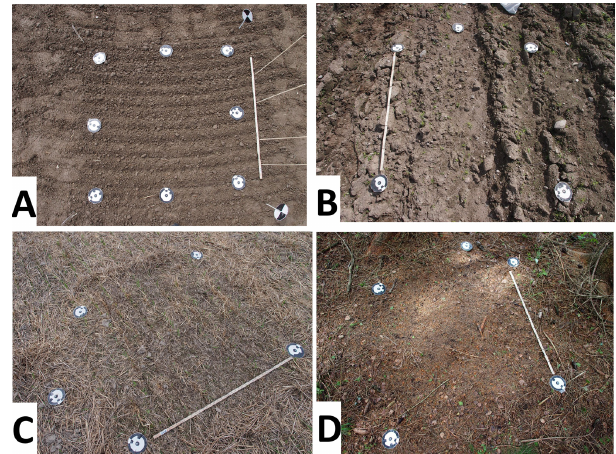
Figure 2. Pictures showing the setup of the measurement plot and the four different land use categories. The markers delineate an area of 1m 2 . The patterns on the markers were used for the stereophoto technique. (a) Harrowed, (b) ploughed, (c) direct seeding on stubble and (d)